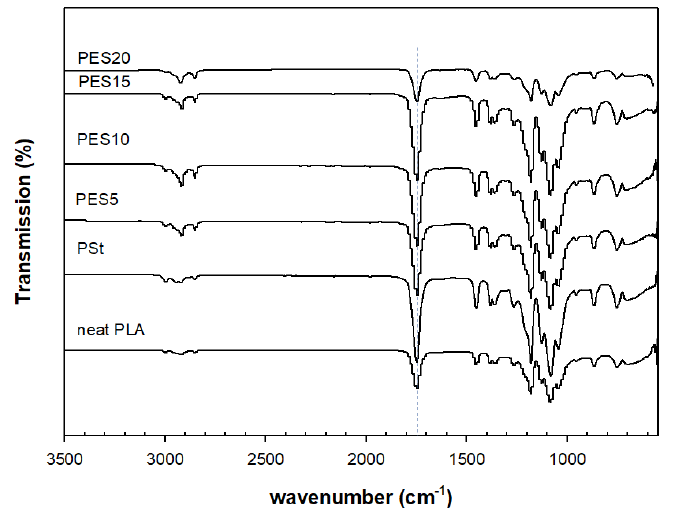
Figure 9. Fourier transform infrared spectroscopy (FTIR) spectrum of neat PLA, PSt, and PSE blends.